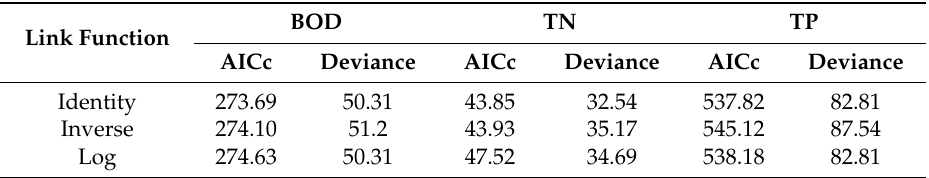
Table 4. AICc and deviance values for BOD, TN, and TP used to select the statistical function for assessing GAMs. The identity function had the lowest AICc and deviance values. Link Function